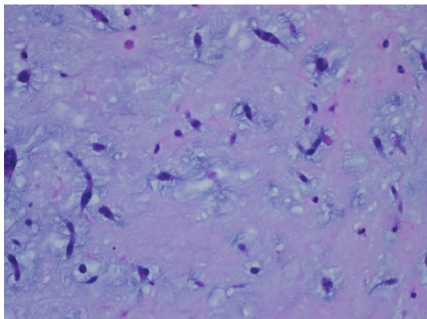
Figure 5: Microphotograph of the surgical specimen showing spin- dle and stellate myxoma cells seen within myxoid stroma (hema- toxylin and eosin, original magnification × 400).